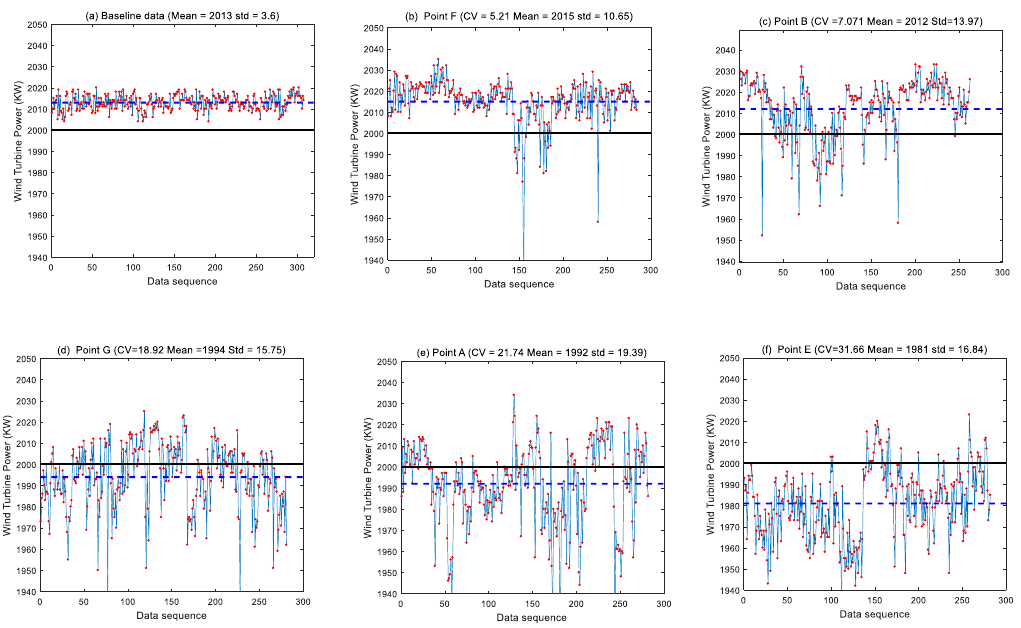
Figure 13. Power time series for different dates (dashed line represents the mean, and the black line indicates the rated power). Table 1. State parameters for different dates.